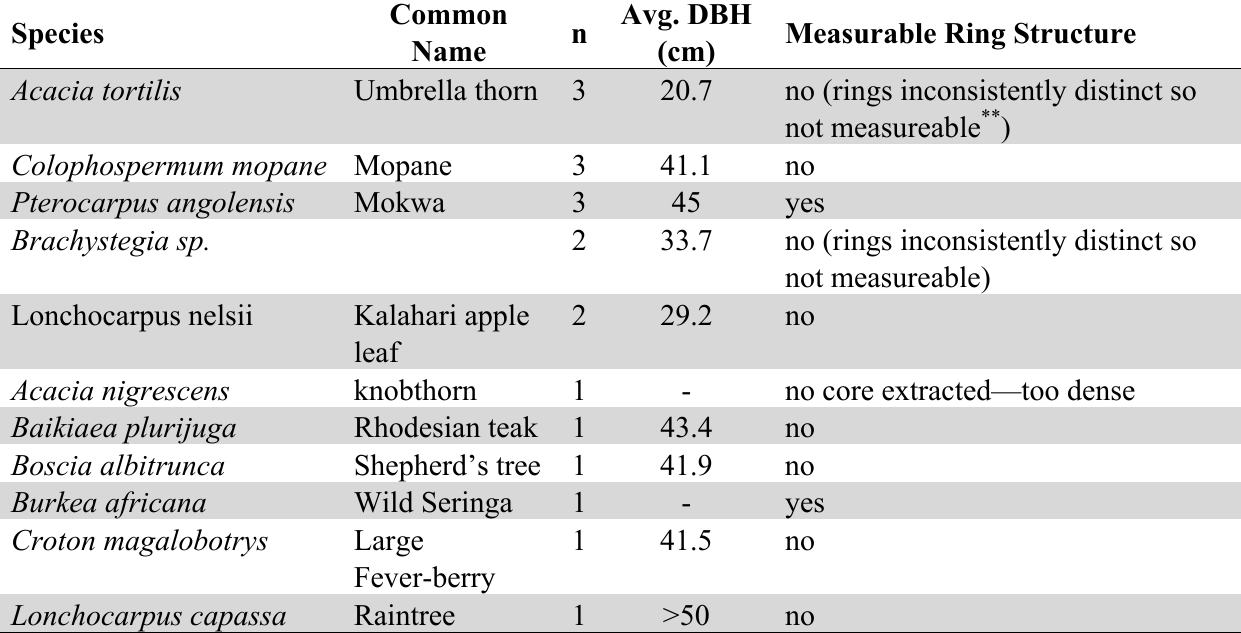
Table 1. Species sampled in the study site, June 2011, n represents the number of trees cored for each